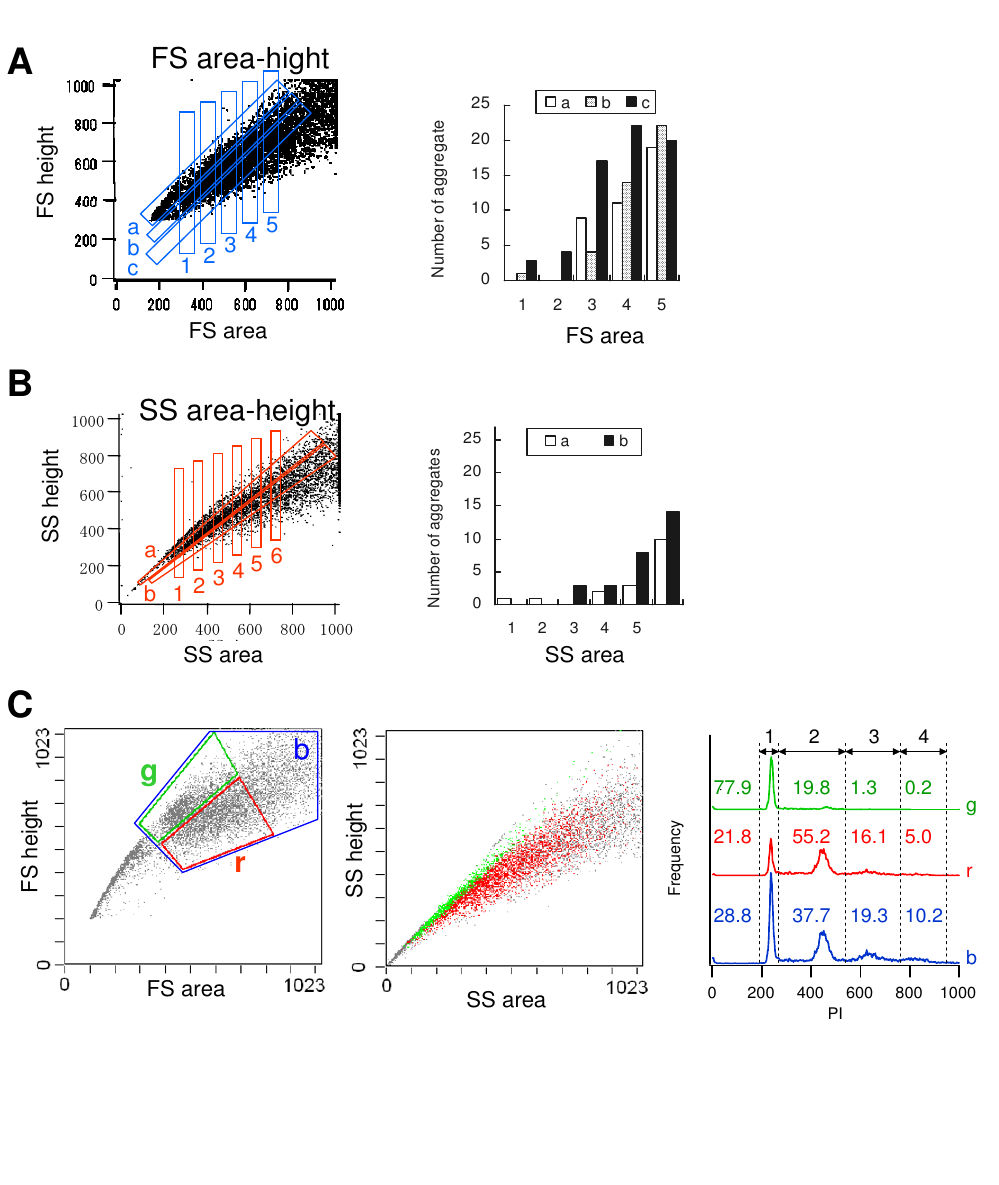
Figure 3 Single and aggregate cell fractions . A, B: Number of aggregates in live cells, which were sorted according to their FS pro- file ( A ) and SS profile ( B ). A: Fifty gates in the FSarea-FSheight profile (left). Particles in each cross-section of gates a-c and gates 1–5 in the FSarea-FSheight profile were sorted. Then, the nuclei per particle were counted, and the number of cell aggregates per twenty-seven particles is shown (right). B: Eleven gates in the SSarea-SSheight profile (left), and the number of aggregates per twenty-seven particles (right). C: FSarea-FSheight (left), SSarea-SSheight (middle), and PI (right) profiles of the ethanol-fixed cells. The green and red dots shown in the SSarea-SSheight profile are the cells within the gate g and r shown in the FSarea- FSheight profile, respectively. Traces g , r and b in the PI profile correspond to gates g , r and b in the FSarea-FSheight profile, respectively. The numbers represent the percentage of cells in regions